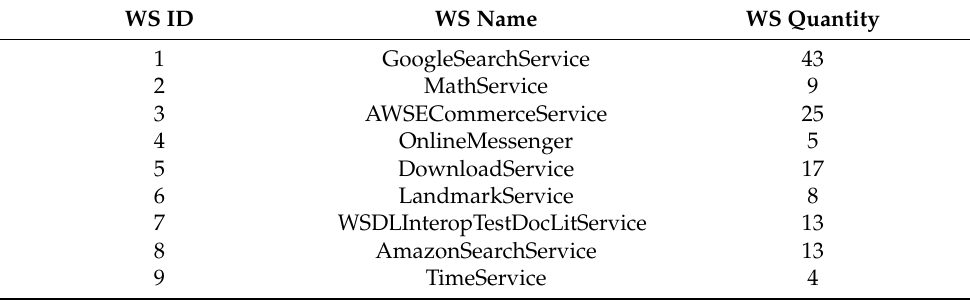
Table 7. Descriptions of the WSs used for testing.